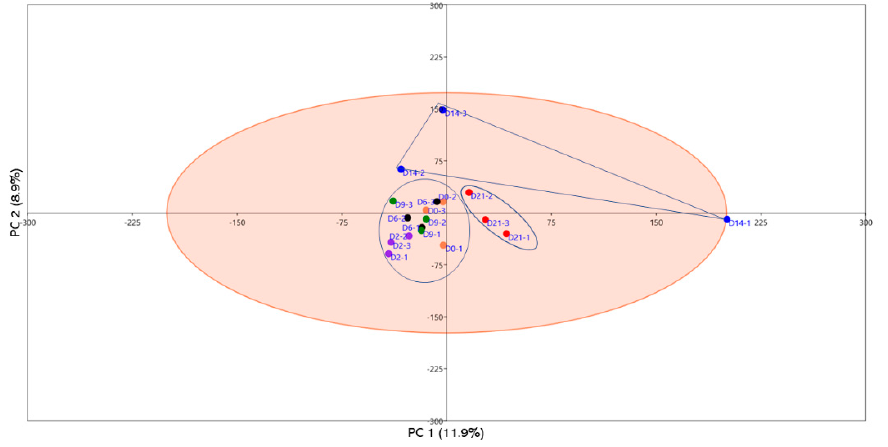
Figure 1. Principal component analysis (PCA) of circulatory miRNAs of blood plasma samples derived from cows subjected to bacterial infection. Samples were collected at day 0 (orange dotes) pre-infection and days 2 (purple dotes), 6 (black dotes), 9 (green dotes), 14 (dark blue dotes), and 21 (red dotes) post-infection. It is shown that the groups from days 14 (dark blue dotes) and 21 (red dotes) showed clear separation from the earlier post-infection periods. Groups are indicated by different color in biological triplicates.